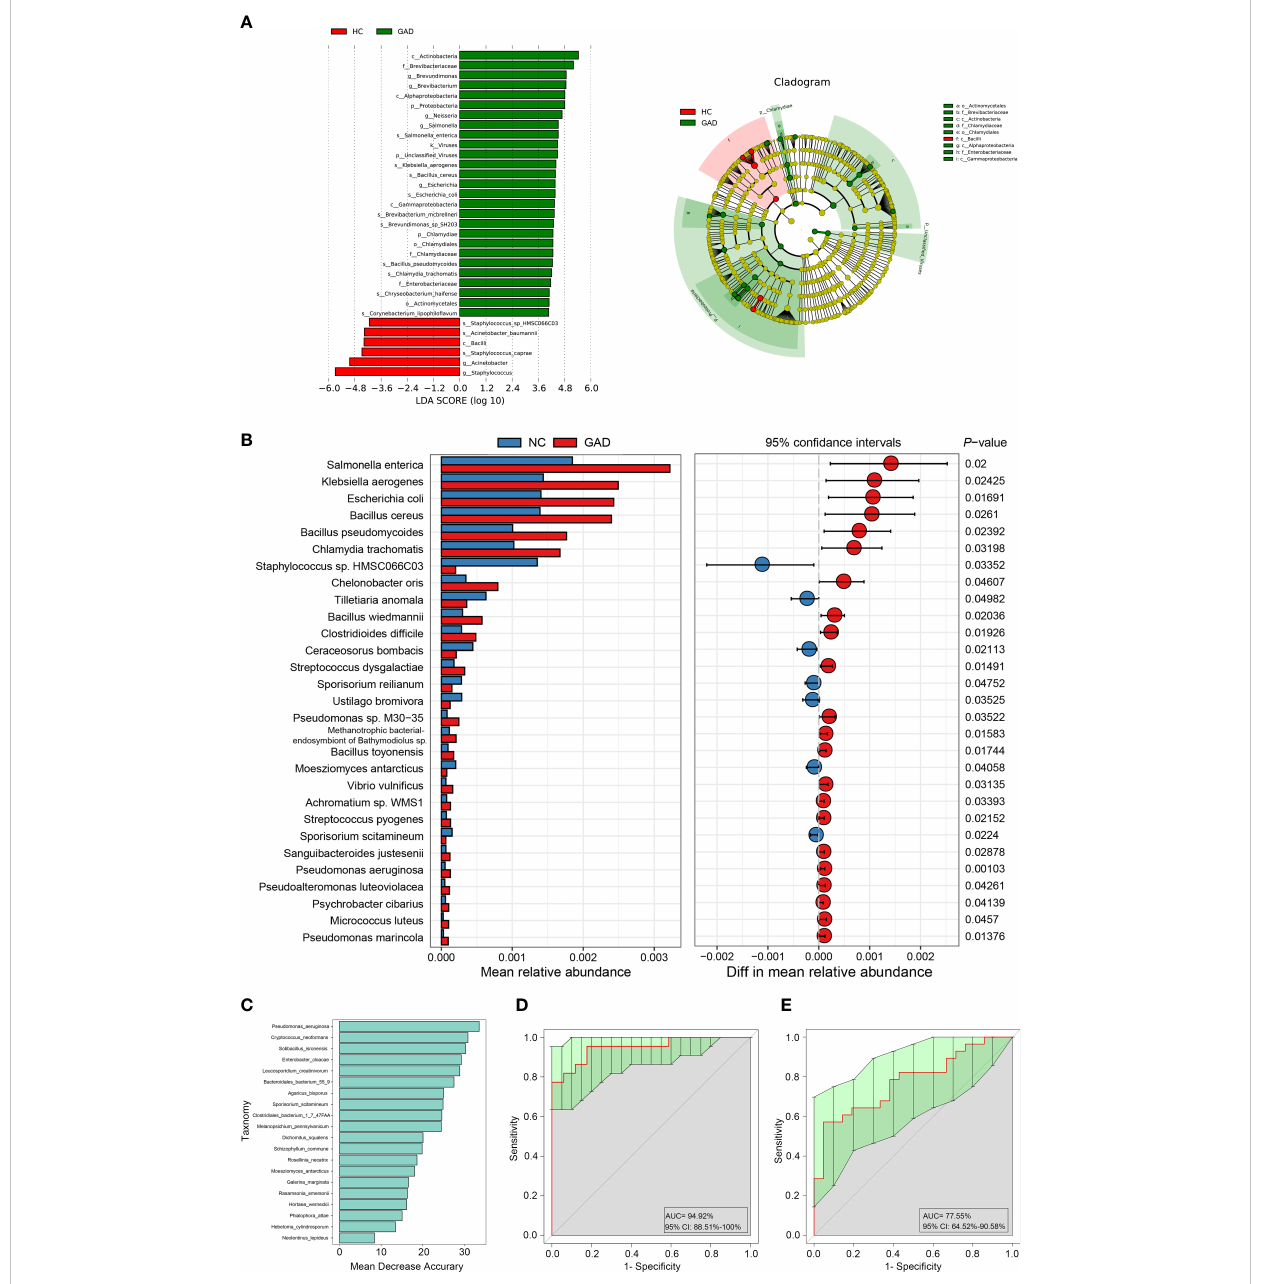
FIGURE 2 Metagenomic sequencing-based exploration of ear canal microbiota in GAD patients. (A) LEfSe analysis revealed signi fi cant bacterial differences in ear canal microbiota between the GAD (positive score) and HC groups (negative score). LDA scores (log10) > 4 and P < 0.05 are shown. These analyses revealed the most differentially abundant taxa at the level of bacterial phylum (p), class (c), order (o), family (f), genus (g), and species(s). (B) Statistical analysis of the ear canal microbiota in GAD and HC groups by Mann-Whitney U test. (C) Top 20 differentially abundant genera markers were selected as the optimal marker set based on random forest between 28 GAD patients and 21 HC. The x-axis presents the mean decrease accuracy to each marker, which indicates the contribution to the accuracy of the model. (D) Receiver operating characteristic curve (ROC) describing the prediction accuracy of model calculated using a 10-fold cross-validation based on top 20 differentially abundant genera markers. Error bars denote 95% con fi dence interval for AUC value. (E) ROC describing the prediction accuracy of model calculated based on the relative abundance of Pseudomonas aeruginosa . Error bars denote 95% con fi dence interval for AUC